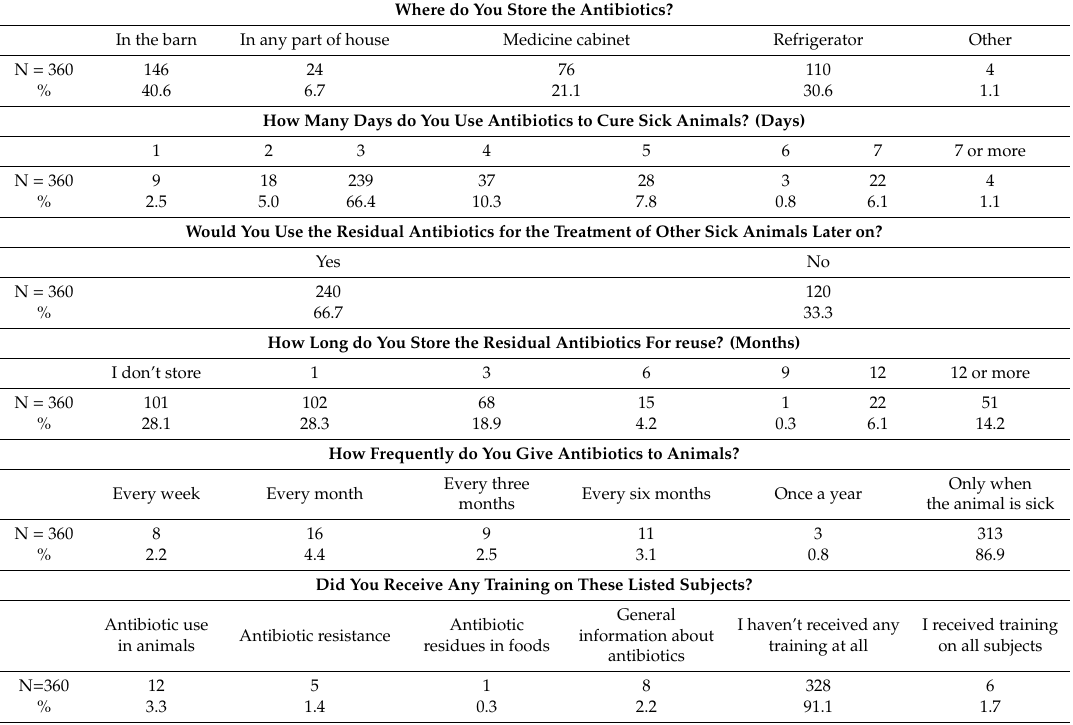
Table 2. The data obtained from the participants about duration of antibiotic use and storage. Where do You Store the